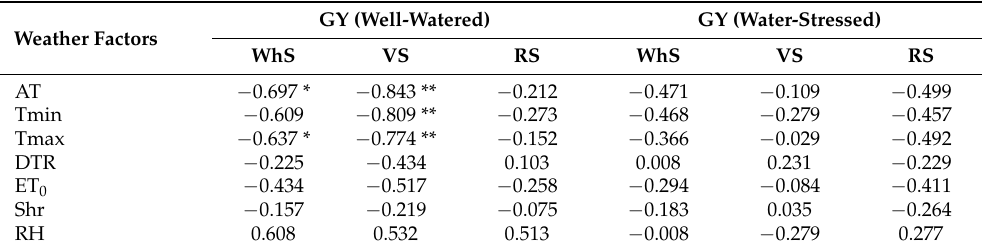
Table 1. Correlation analysis of grain yield of foxtail millet under water-stressed and well-watered conditions with weather factors during vegetative, reproductive and whole growing stages for variety Jigu19.